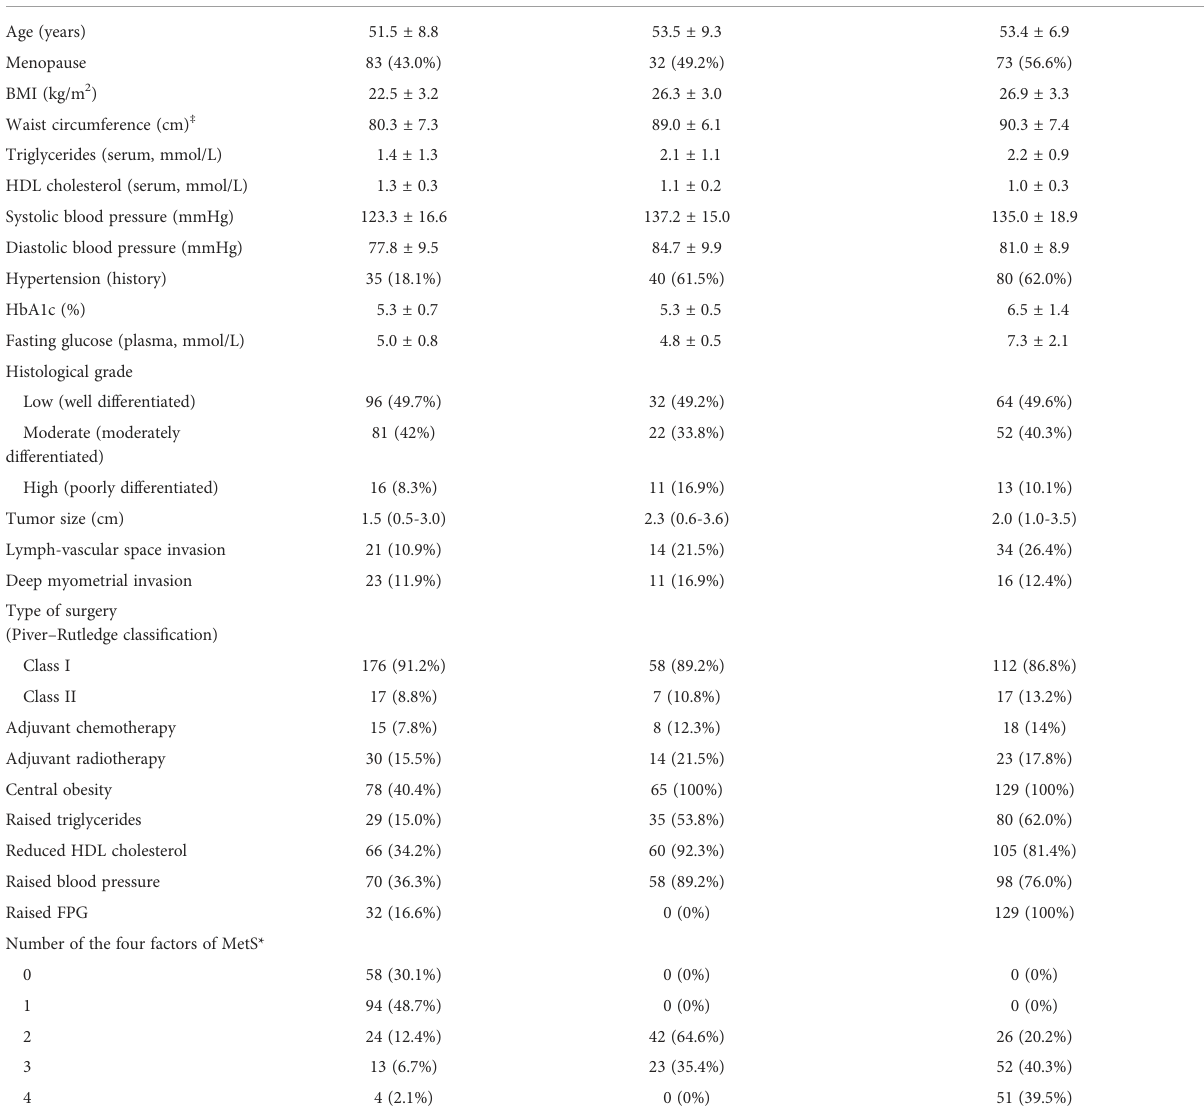
TABLE 3 Patient characteristics at baseline according to subtypes of metabolic syndrome. Patient